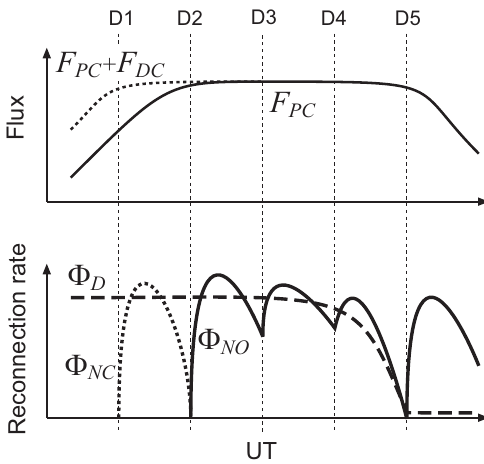
Fig. 13. A schematic representation of the open and dim-closed magnetic flux inside the auroral oval, and day- and nightside recon- nection rates during the substorm (see text for